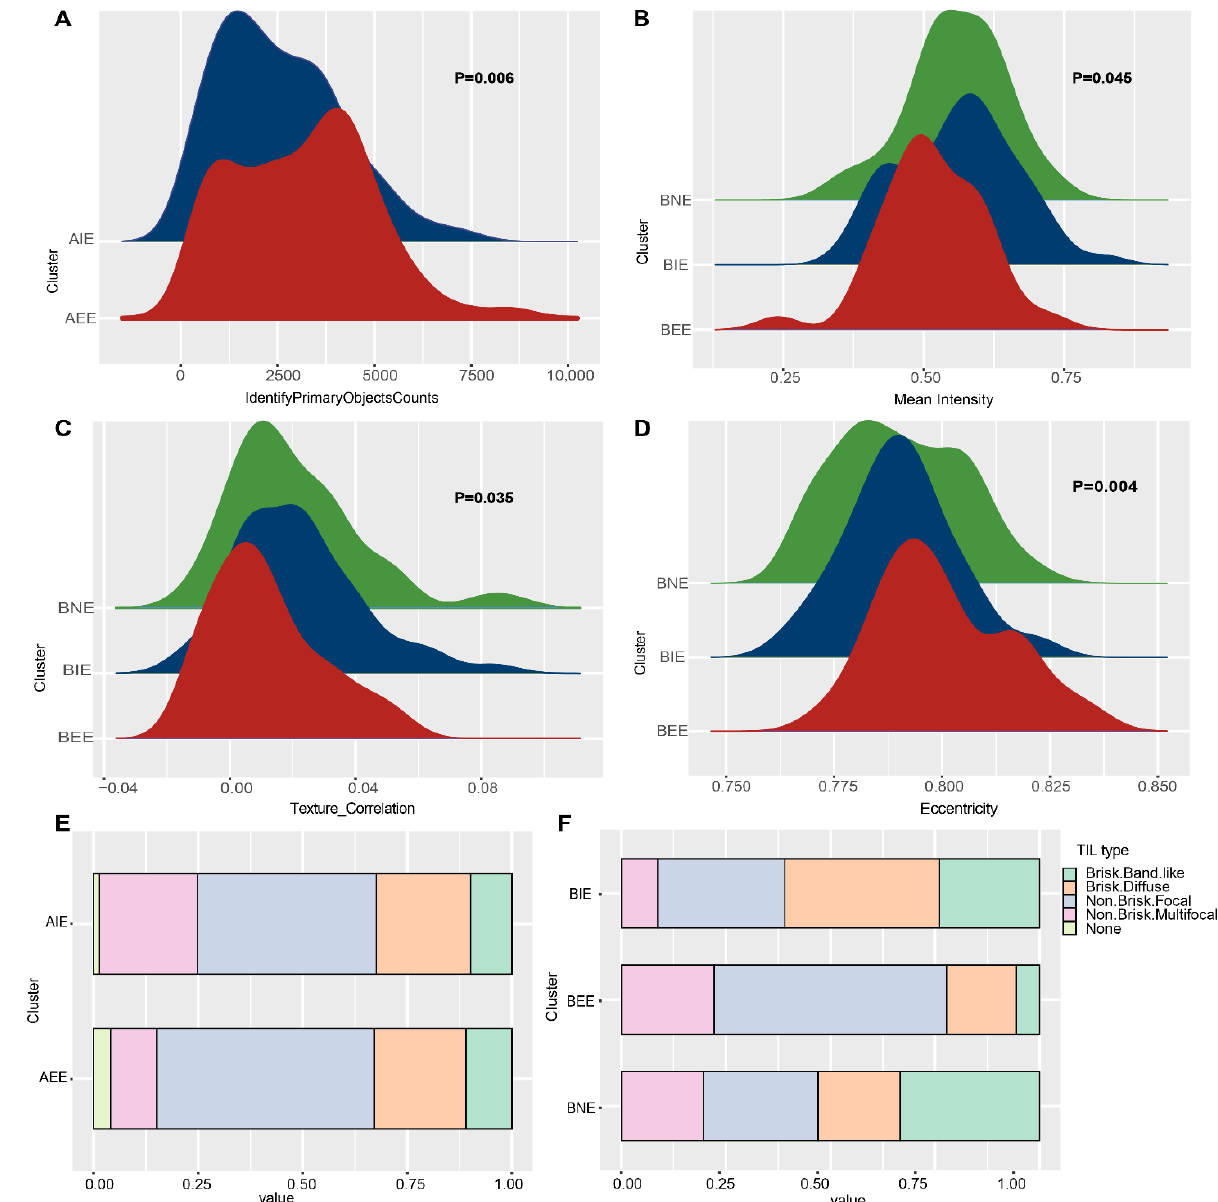
Figure 5. Images differences in luminal A/B subgroups. ( A ) The differences in “IdentityPrimaryOb- jectsCounts” between luminal A subgroups. ( B ) The differences in “Mean Intensity” between luminal B subgroups. ( C ) The differences in “Texture Correlation” between luminal B subgroups. ( D ) The differences in “Eccentricity” between luminal B subgroups. ( E ) The differences of TILs type between luminal A subgroups. ( F ) The differences of TILs type between luminal B subgroups.